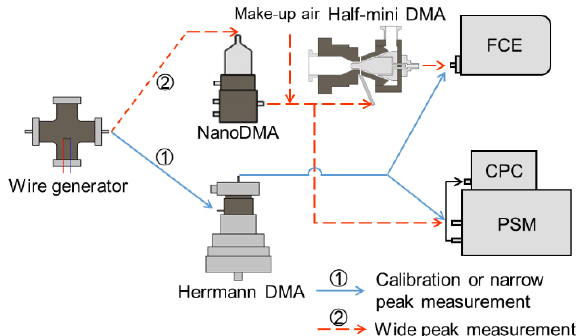
Figure 3. The experimental set-up to calibration the PSM and test the inversion